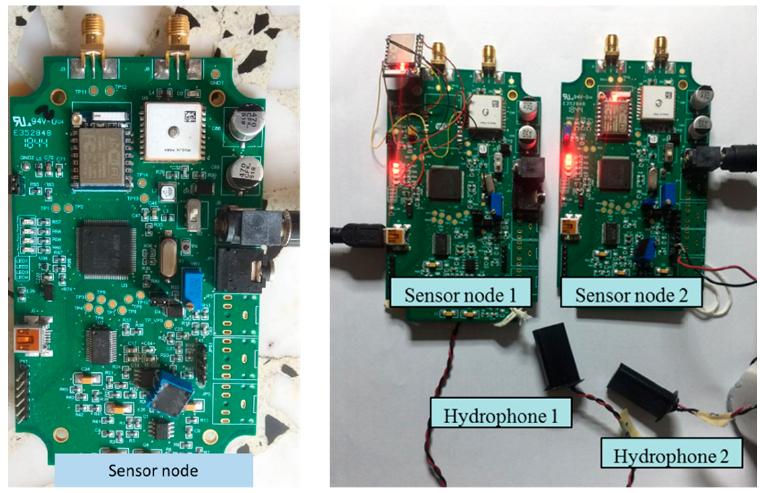
Figure 5. Overview of developed wireless sensor node platform.